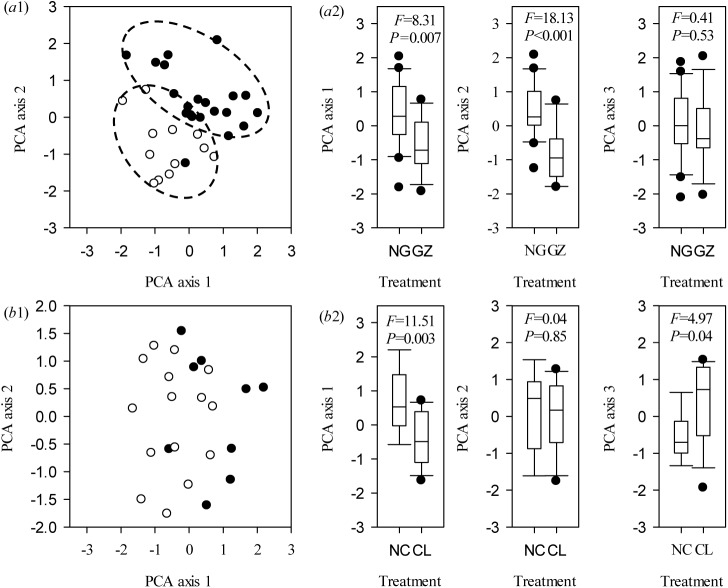
PCA bi-plot of Leymus chinensis (Trin.) Tzvelev functional traits for hydroponic treatment based on the variance in 10 functional traits explained by the first (PCA 1), second (PCA 2), and third (PCA 3) principal axes.(a1) and (b1): PCA ordination of Leymus chinensis (Trin.) Tzvelev plants from the ungrazed or unclipped (solid circle) and grazed or clipped (empty circle) treatments in hydroponic conditions, respectively. (a2) and (b2): Box plots illustrate the score distribution of Leymus chinensis (Trin.) Tzvelev functional traits from different communities along the three principal axes. Abbreviations are as described in Fig 1.